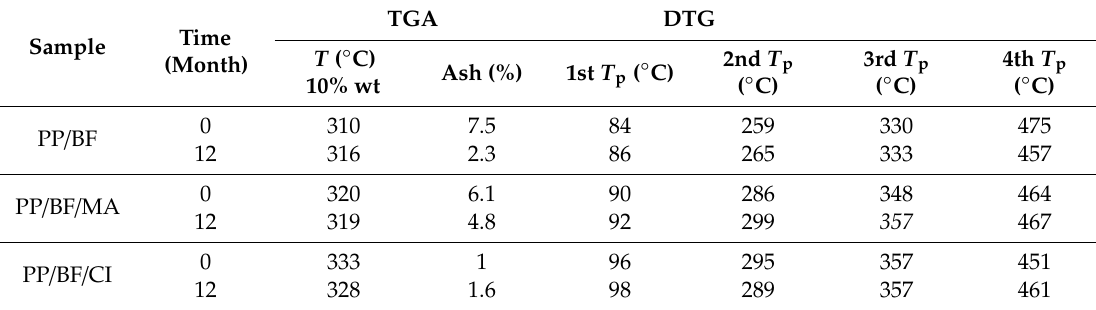
Table 4. Results of the thermal properties (TGA and DTG) of composites